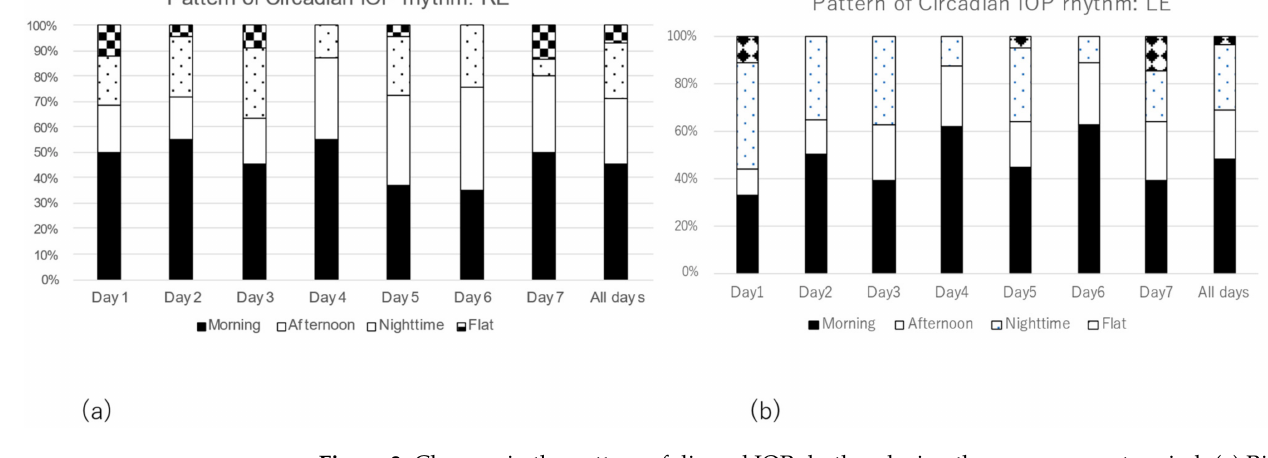
Figure 3. Changes in the pattern of diurnal IOP rhythm during the measurement period. ( a ) Right eye, ( b ) Left